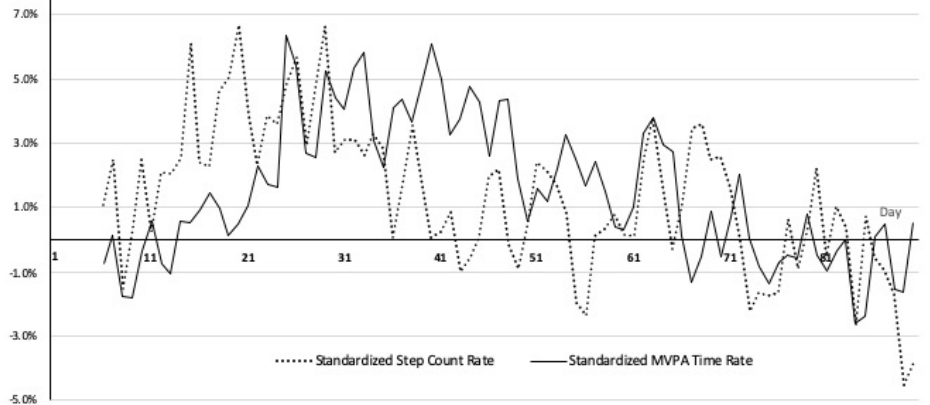
Figure 2. Standardized step count rate and Standardized MVPA time rate.